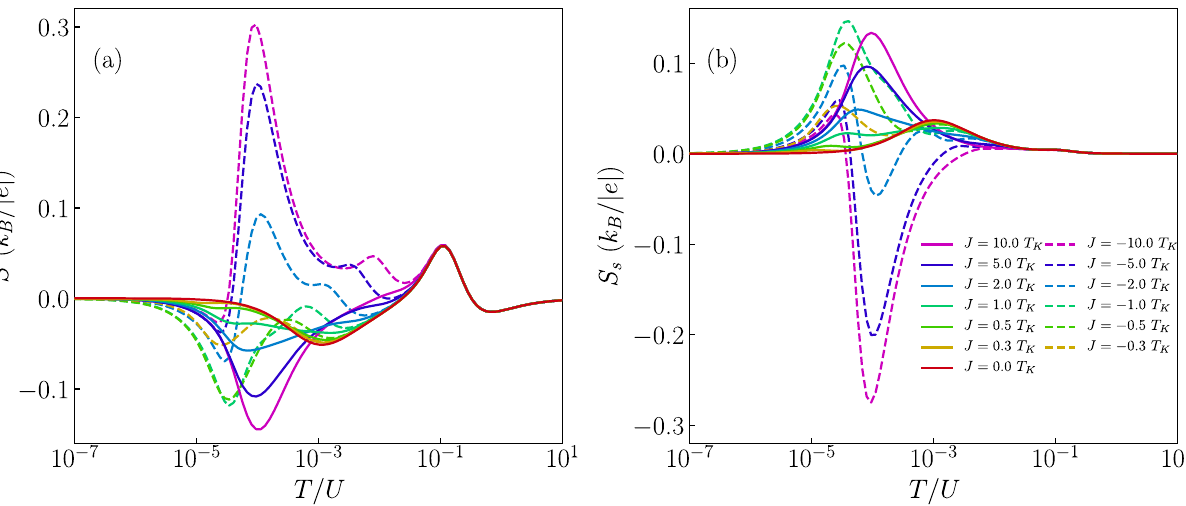
Figure 9. Spin thermopower for different values of exchange interaction. ( a ) The Seebeck and ( b ) spin Seebeck effect as a function of temperature for different values of exchange interaction J , as indicated. The parameters are the same as in Fig. 5 with ε = − 0.48 U .